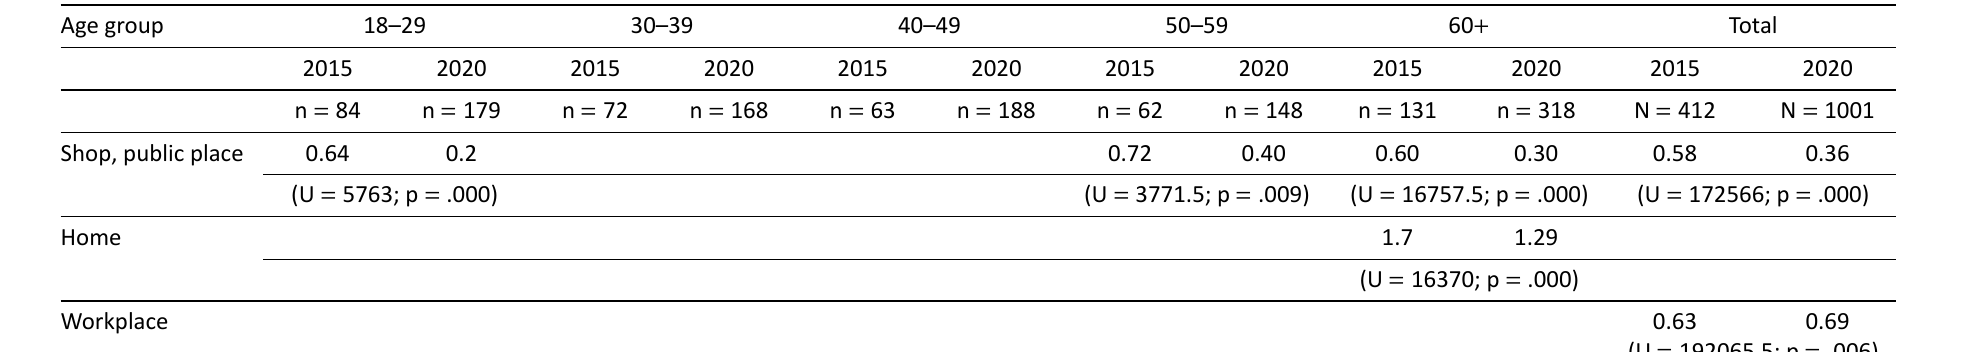
Table 6. Mean number of contacted alters (per day) by respondents’ age and the place of meeting (with Bonferroni Mann‐Whitney U tests; only significant values). Age